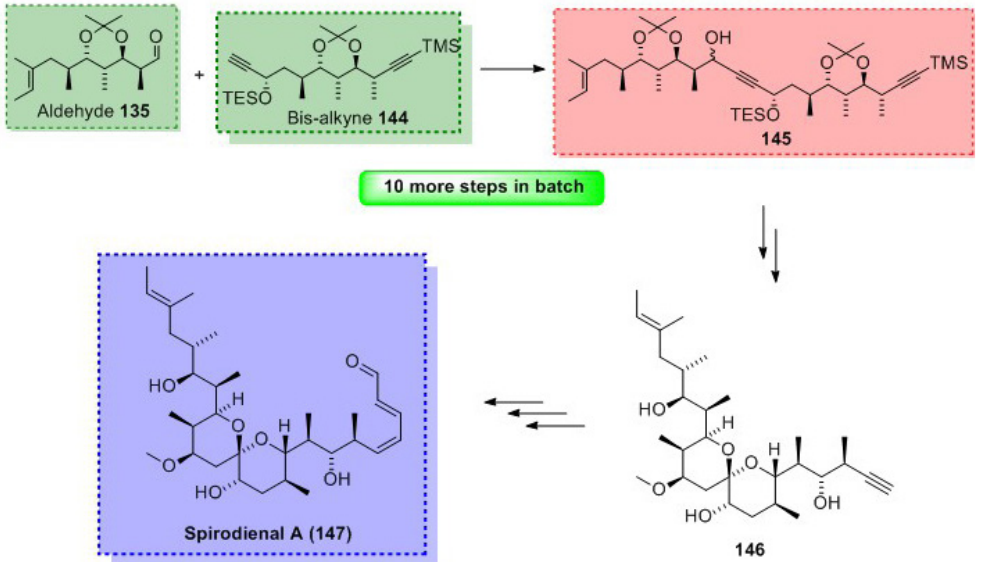
Scheme 33 - Final steps of the spirodienal A ( 147 )